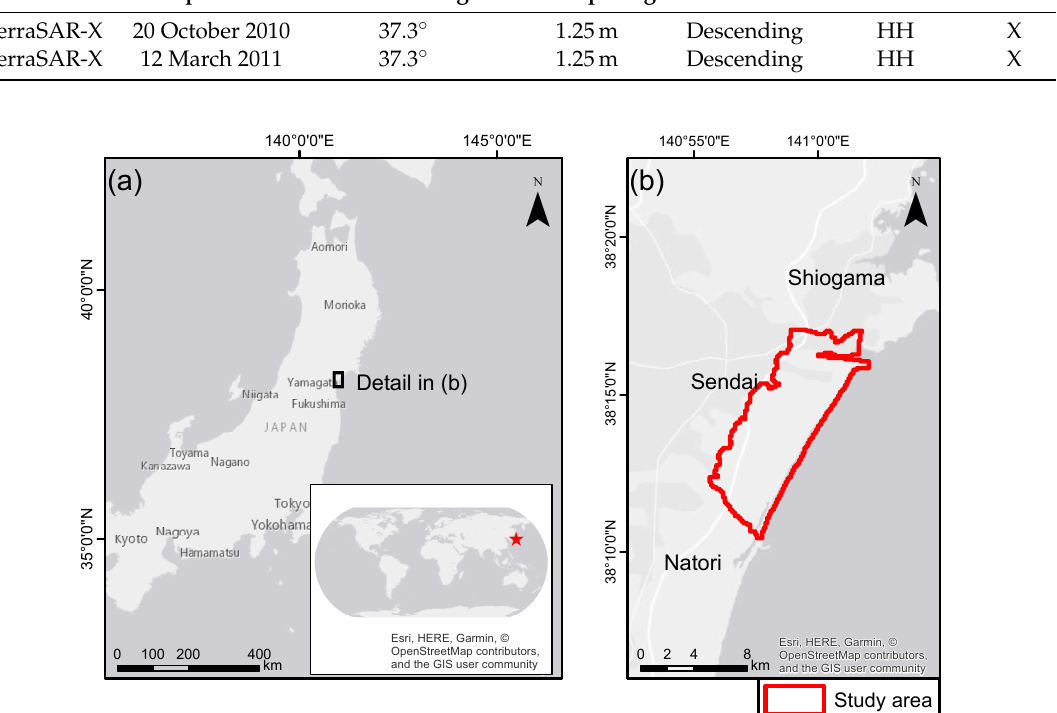
“G5: moderate damage,” “G4: major damage,” “G3: complete damage,” “G2: collapsed,” and “G1: washed